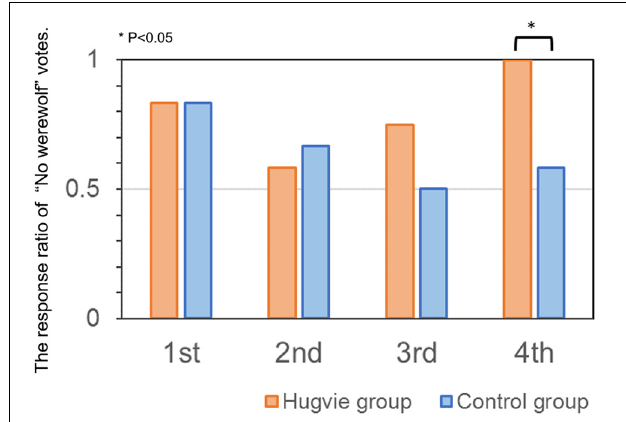
FIGURE 4 | Ratio of “No werewolf” votes for each round and group.